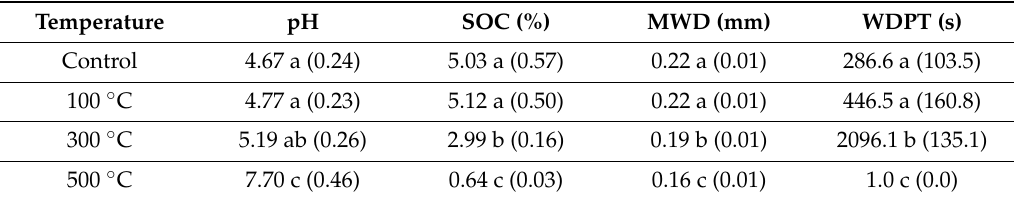
Table 7. Mean values ( ± standard deviation) for pH, SOC, MWD and WDPT test in relation to heating temperature. The Kruskal–Wallis post hoc results are shown. Different letters in each column indicate significant differences among different heating temperatures for this variable.